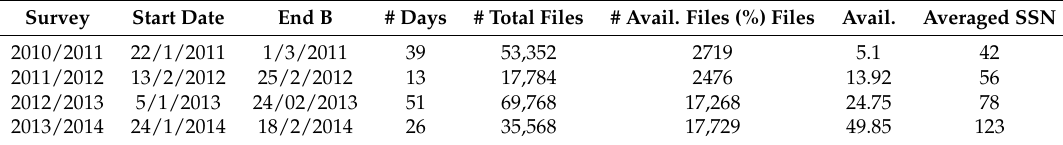
Table 1. Details of the four studied campaigns. SSN: Sun spot